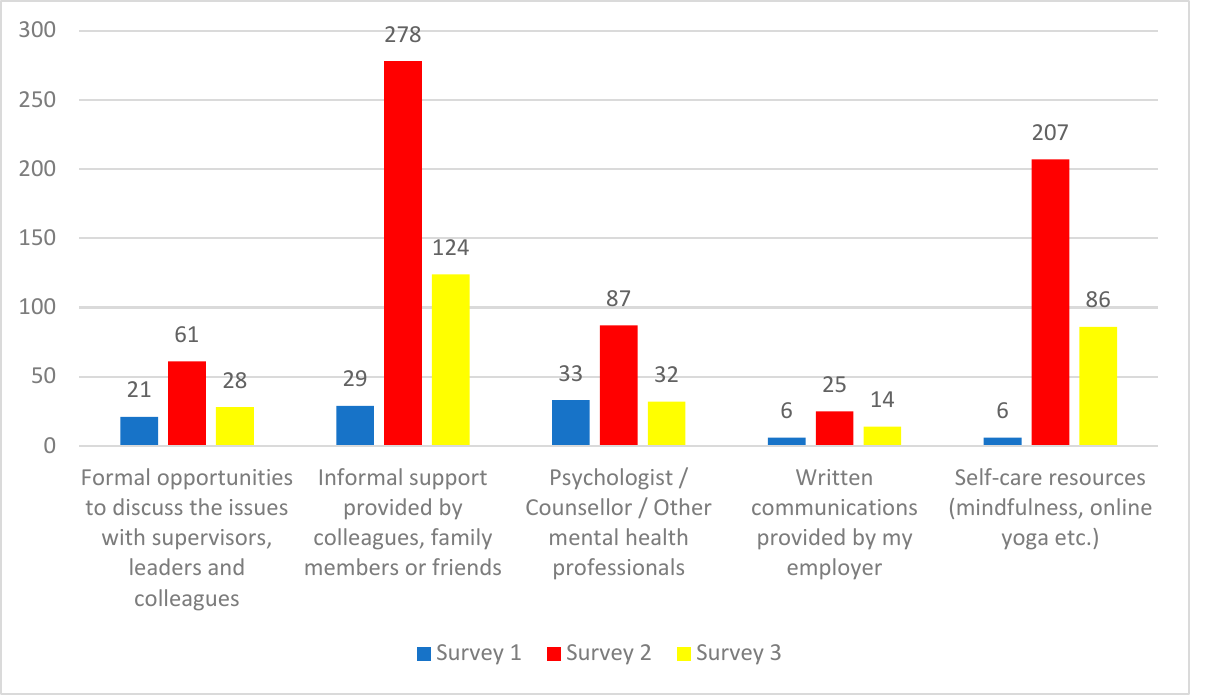
Figure 7. Sources of support to cope with negative psychological impacts of COVID-19. Since participants could select multiple themes, it is not possible to calculate percentages.